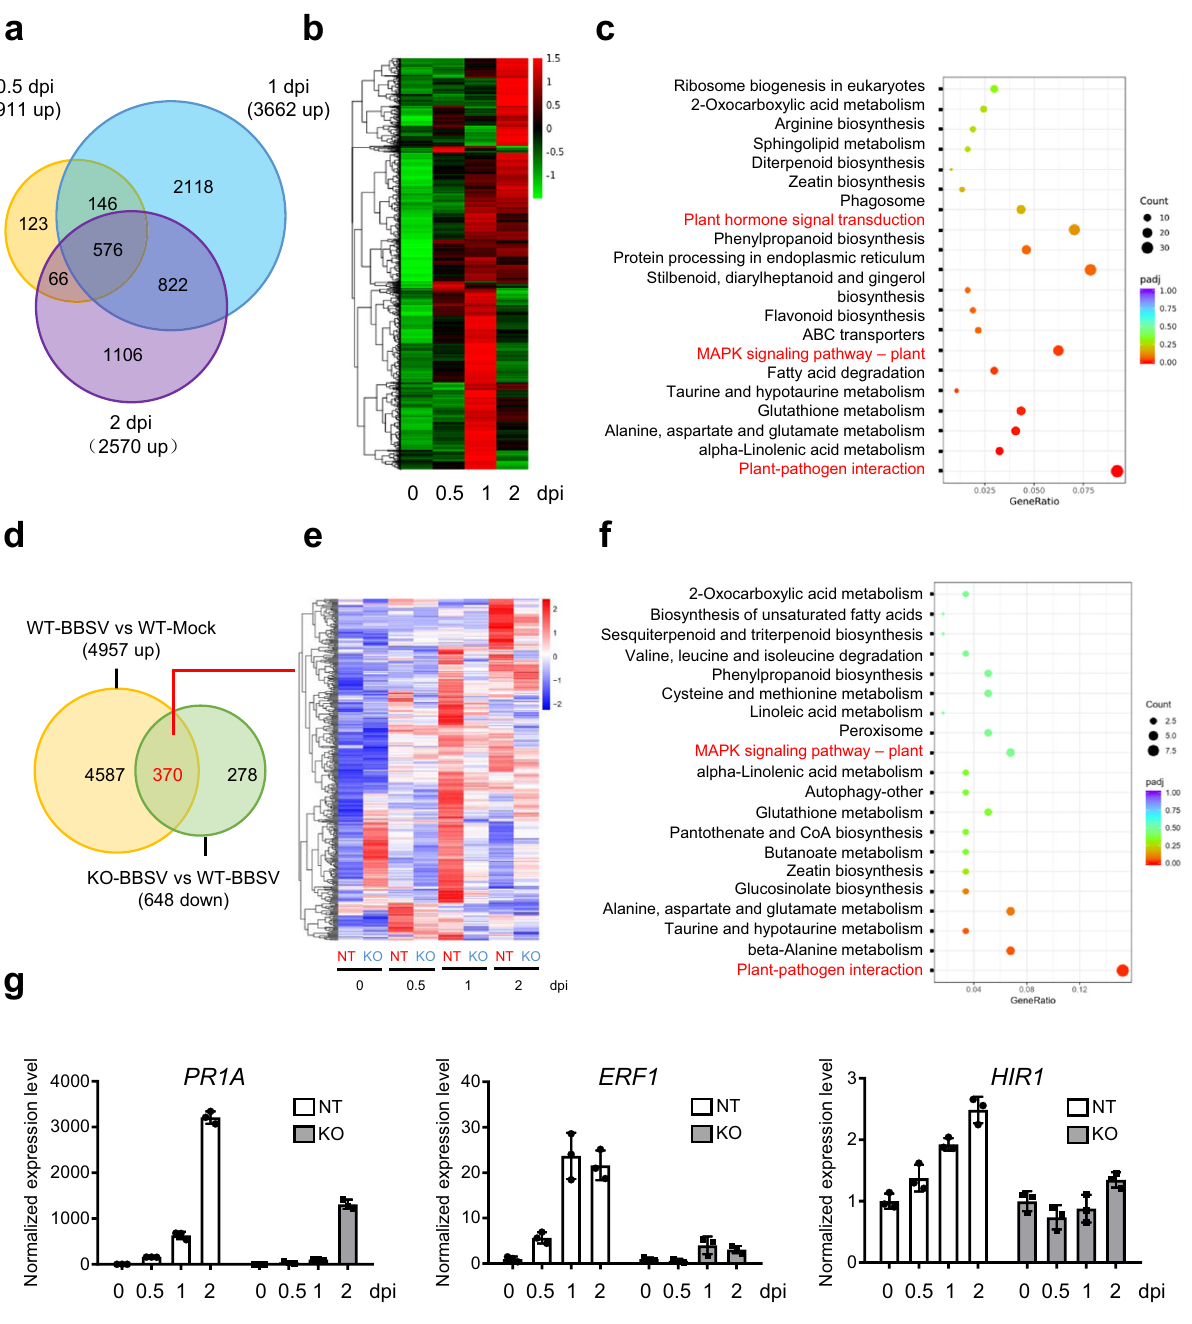
Fig. 2 RNA-seq analyses of non-transgenic and MAPKKK α -KO plants in response to BBSV infection. a Venn diagrams showing overlaps of upregulated genes in WT-BBSV at different time points vs WT-Mock. b Heatmaps showing hierarchical cluster analysis of all differentially expressed genes. Data were collected from three biological replicates, each containing a pool of three individual plants. The resulting P values were adjusted using Benjamini and Hochberg ’ s approach for controlling the false discovery rate (padj). P adj < = 0.05 and |log2(foldchange)| > = 1 were set as the threshold for signi fi cantly differential expression. c The Kyoto Encyclopedia of Genes and Genomes (KEGG) enrichment analyses of all upregulated genes in BBSV-infected plants. d Venn diagrams showing overlaps of 4957 upregulated genes in WT-BBSV vs WT-Mock and 648 downregulated genes in KO-BBSV vs WT-BBSV. e Heatmaps showing hierarchical cluster analysis of 370 differentially expressed genes shown in ( d ). f KEGG enrichment analyses of 370 differentially expressed genes shown in ( d ). g RT-qPCR assay to validate the accuracy of the transcriptome data for these differentially expressed genes shown in ( d ). EF-1 α was used as the internal reference gene to normalize the relative expression. Values are mean ± SD from three biological the positive control (Supplementary Fig. 4b). These results followed by silver staining. A distinct band was visible in the IP indicate that CP does not directly interact with MAPKKK α . products from CP-3×FLAG but the corresponding band was To identify the targets of BBSV CP that could interfere with the absent in the lane of GFP-3×FLAG control (Fig. 3c). The band MAPKKK α activity, we performed immunoprecipitation (IP) of was excised from the gel and analyzed by liquid chromatography CP-3×FLAG and separated immunoprecipitates by SDS-PAGE coupled to tandem mass spectrometry (LC-MS/MS). Several